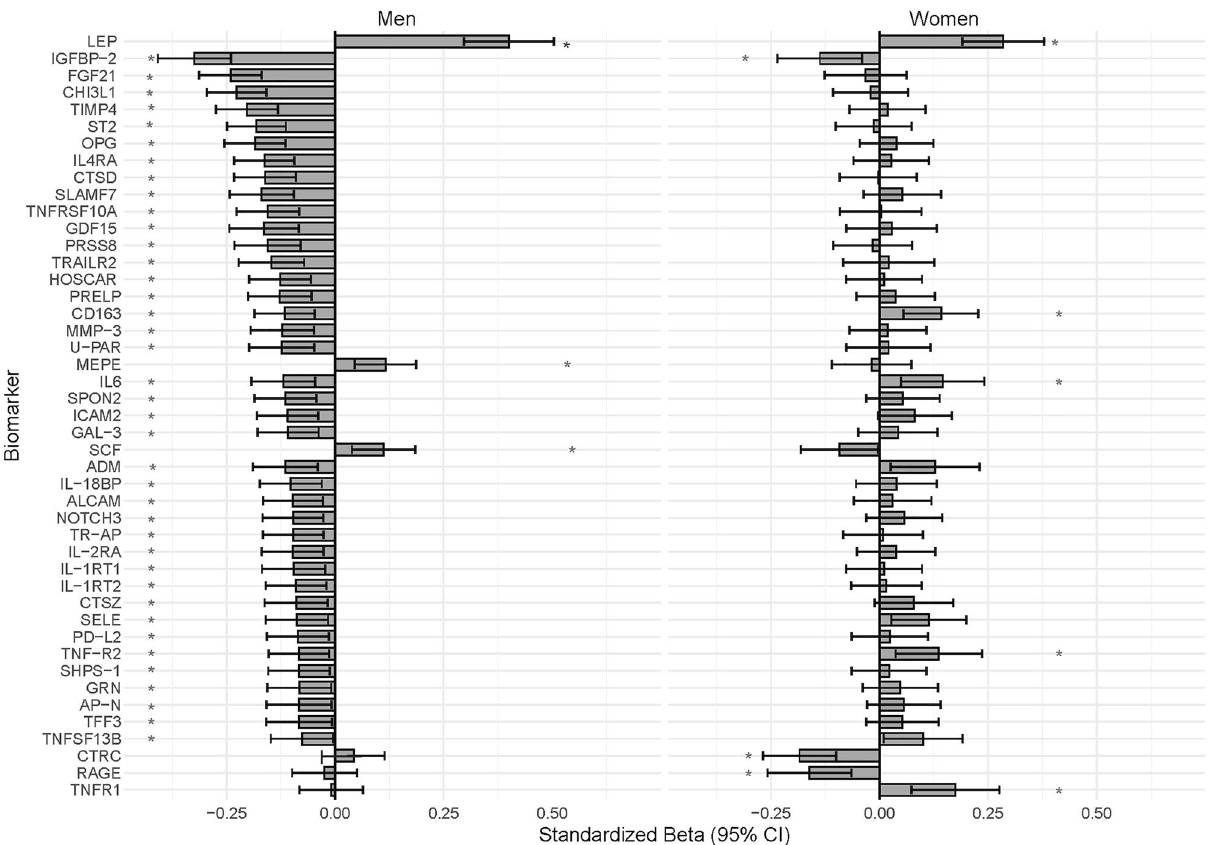
Figure 2. Sex-stratified associations between biomarkers and ASM. Only the 45 biomarkers that showed significant sex interaction and were significantly associated with ASM in at least one of the sex groups are shown. Linear regression models were adjusted for age, height, sex, smoking, alcohol, HFIAS total score, total physical activity (ENMO), visceral adipose tissue, and HIV status. Menopause status was included as an additional confounder in women. *False-discovery rate adjusted P value < 0.05; Standardized Beta: Standardized Beta coefficient; 95% CI 95% Confidence Intervals. Full names of all biomarkers are listed in Additional Table